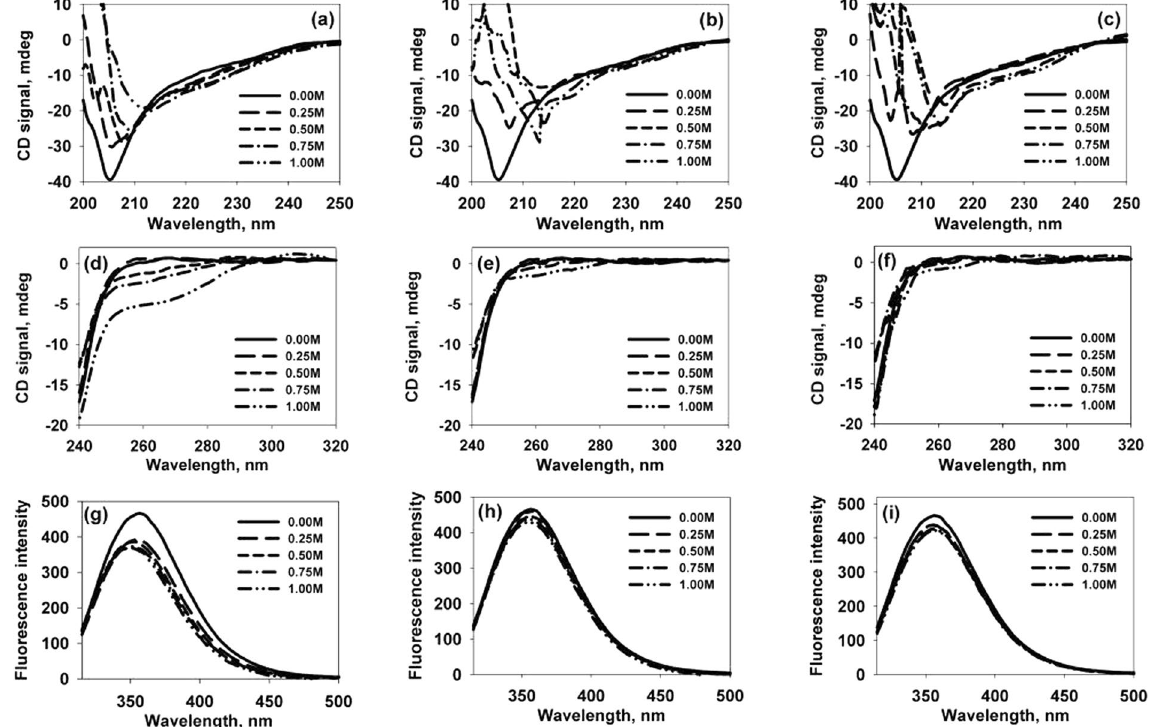
Figure 1. Conformational changes in α -casein by TMAO, sarcosine and betaine: Far- UV CD spectra ( a , b , c ), near-UV CD spectra ( d , e , f ) and intrinsic tryptophan fluorescence ( g , h , i ) of α -casein in presence of TMAO, sarcosine and betaine respectively. Left panel is of TMAO, middle of sarcosine and right one of betaine. Symbols at the right corner denote different concentrations of TMAO, sarcosine and betaine. These data were collected immediately after the sample